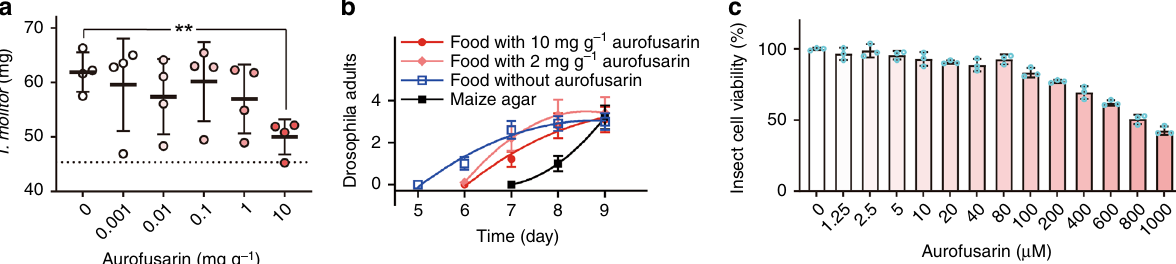
Fig. 5 Toxicity of aurofusarin to arthropods. a The weight of T. molitor after 10 d of feeding on wheat with different concentrations of aurofusarin. The average initial weight is indicated by the dashed line. Means and SD of 4 replicates, each with 10 animals, are shown. The effect of aurofusarin at 10 mg g − 1 was analysed with two-sided t tests (10 individuals per experiment, n = 4, p = 0.0027). b The developmental toxicity of aurofusarin was tested by feeding larvae of Drosophila melanogaster on food with and without aurofusarin for two days, followed by incubation on standard food to accomplish the development (10 larvae per arena, 10 arenas per treatment, error bars show s.e.m.). Maize agar was used to simulate starvation. c The viability of Sf9 cells (fall armyworm Spodoptera frugiperda ) after 24 h of incubation with aurofusarin ( n = 3) shown as means with error bars showing s.e.m. The coloration of data points and bars indicates aurofusarin concentration in fl our. Source data are provided in a Source Data fi le